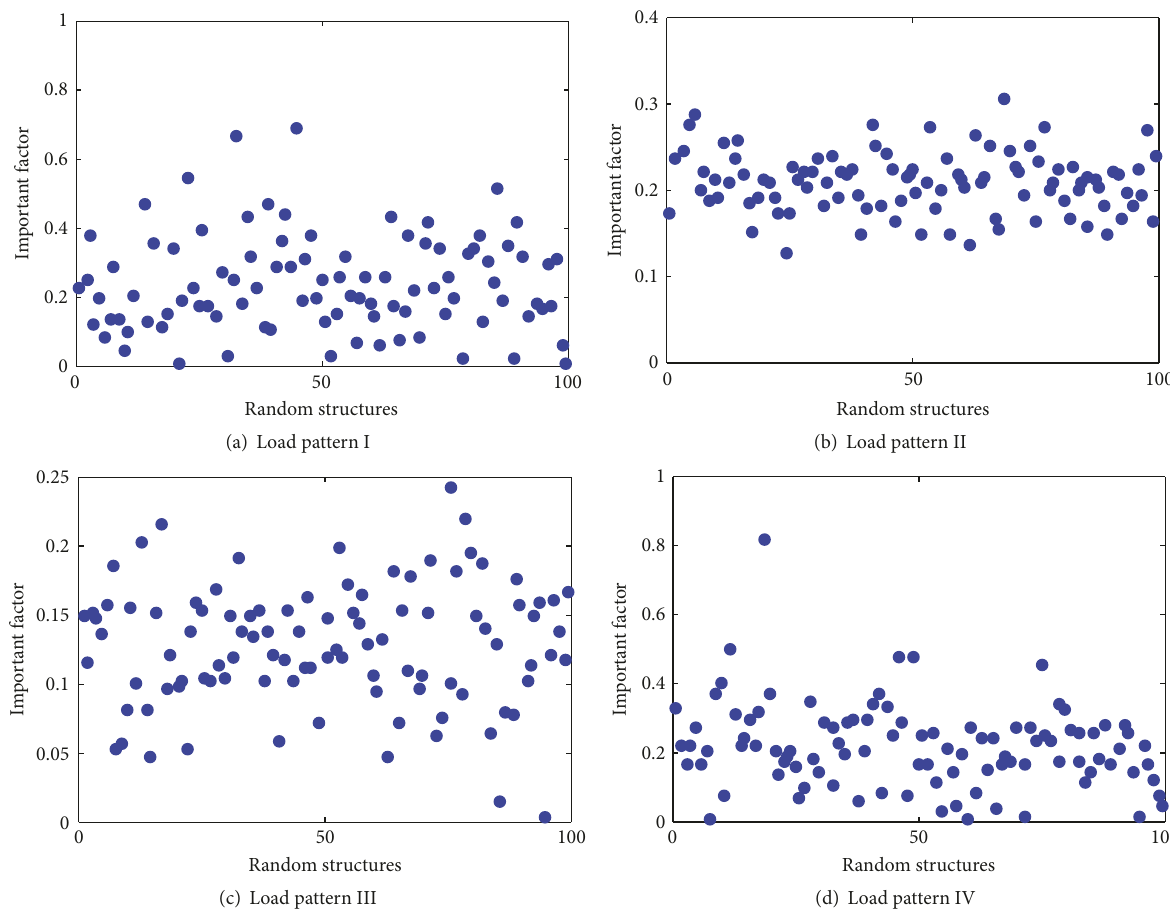
Figure 8: The first important factor of component 51.